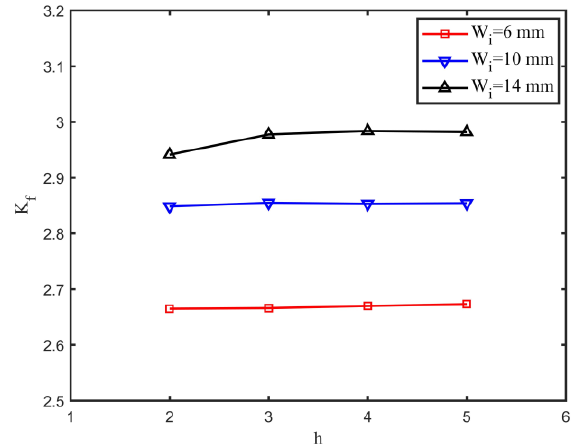
Figure 7. The effect of weld root bead height h (δ = 0, θ = 50°).